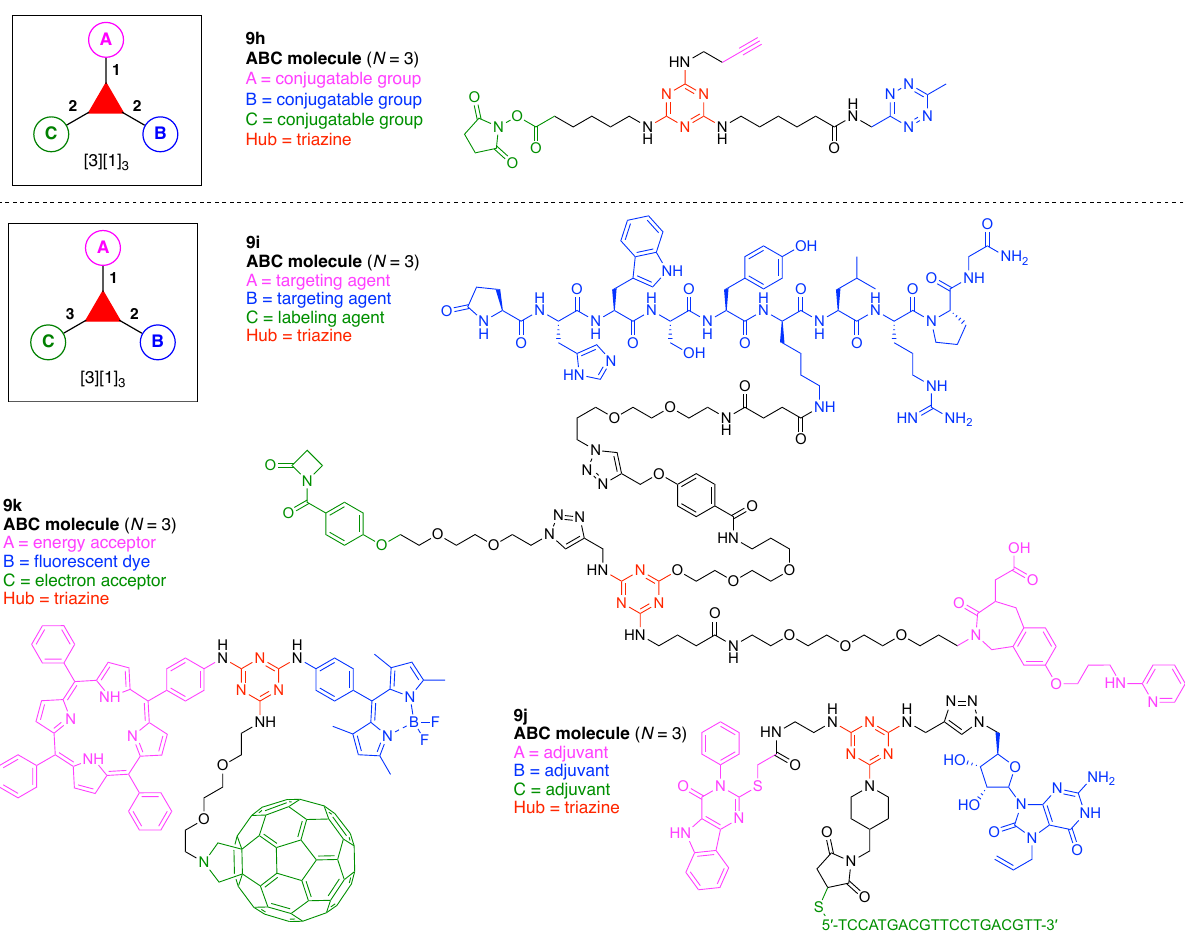
A trifunctional linker for “double-click” labeling ( 9h ) has been developed (Figure 37) [227].